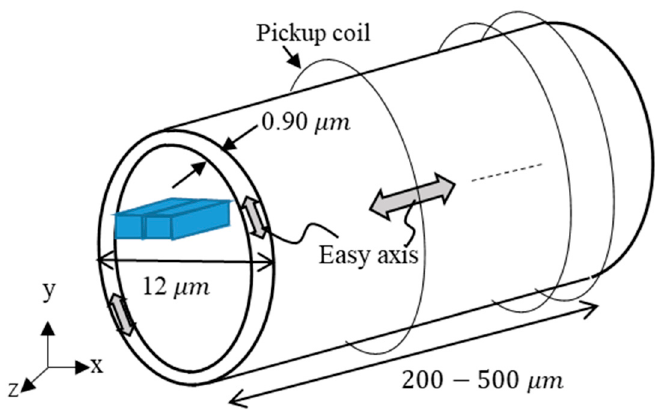
Figure 8. Schematic diagram of the amorphous wire for an axial length of 200–500 μ